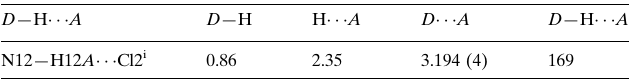
Hydrogen-bond geometry (A˚ , (cid:4)